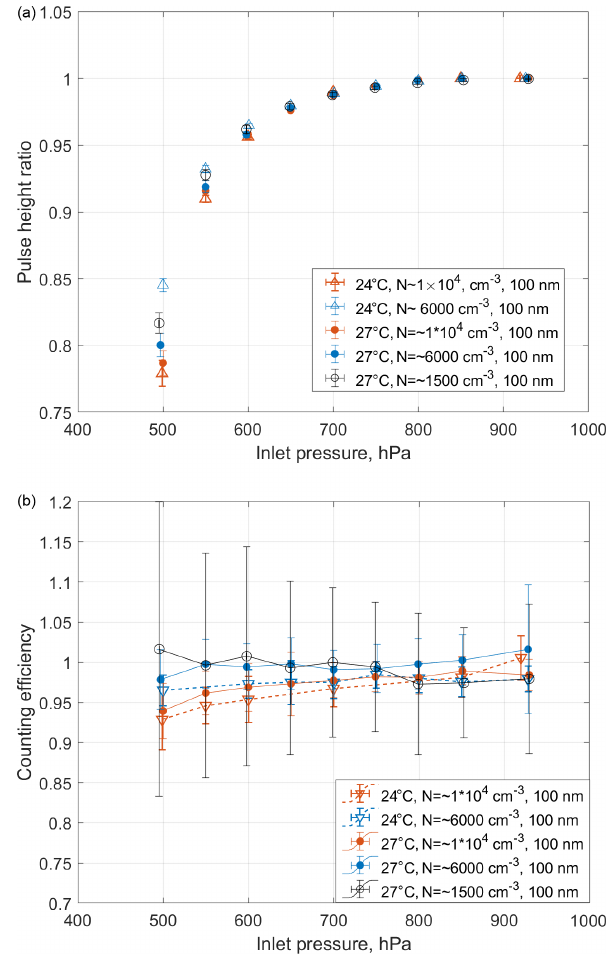
Figure 7. The water depletion due to the aerosol number concen- tration, as illustrated by (a) the pulse height generated in the optical detector and (b) the counting efficiency as a function of the inlet pressure. Results are shown with the conditioner temperatures set at 24 and 27 ◦ C.